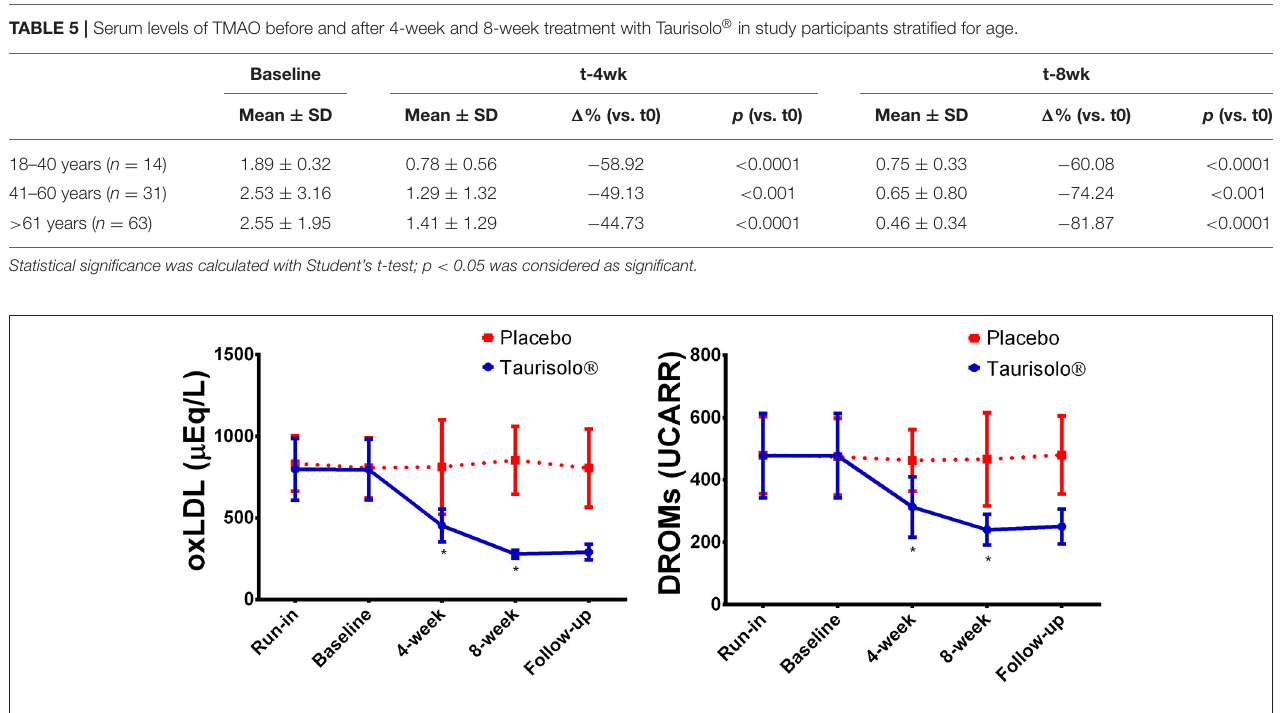
FIGURE 3 | Graphical representation of the oxidative stress-related biomarkers serum levels at the different time points. Values are expressed as mean ± standard deviation. Statistical significance was calculated with Student’s t -test; p < 0.05 was considered as significant. * P < 0.0001, Taurisolo ® group, compared to